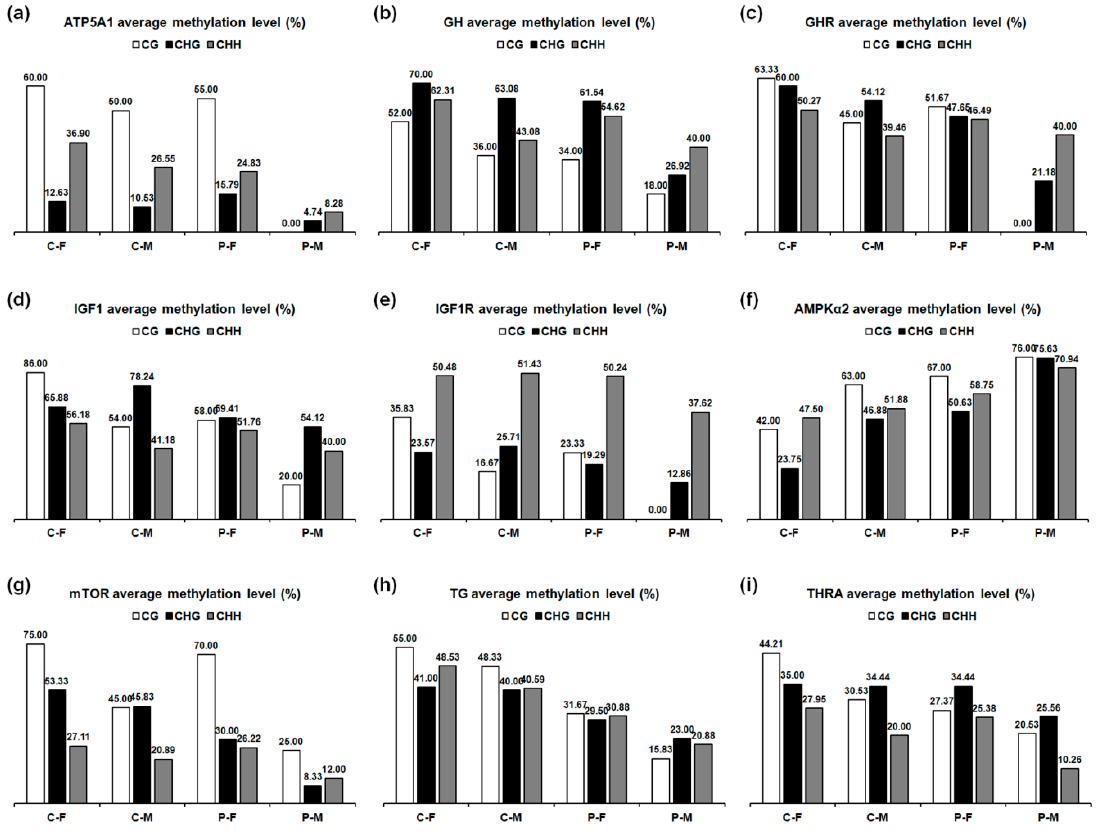
Figure 9. Average methylation levels for CG, CHG, and CHH sites in 90-day-old chickens. Average methylation levels in the sequenced regions of ( a ) ATP5A1 , ( b ) GH , ( c ) GHR , ( d ) IGF1 , ( e ) IGF1R , ( f ) AMPK α 2 , and ( g ) mTOR in the skeletal muscles, ( h ) TG , and ( i ) THRA in the thyroid glands.